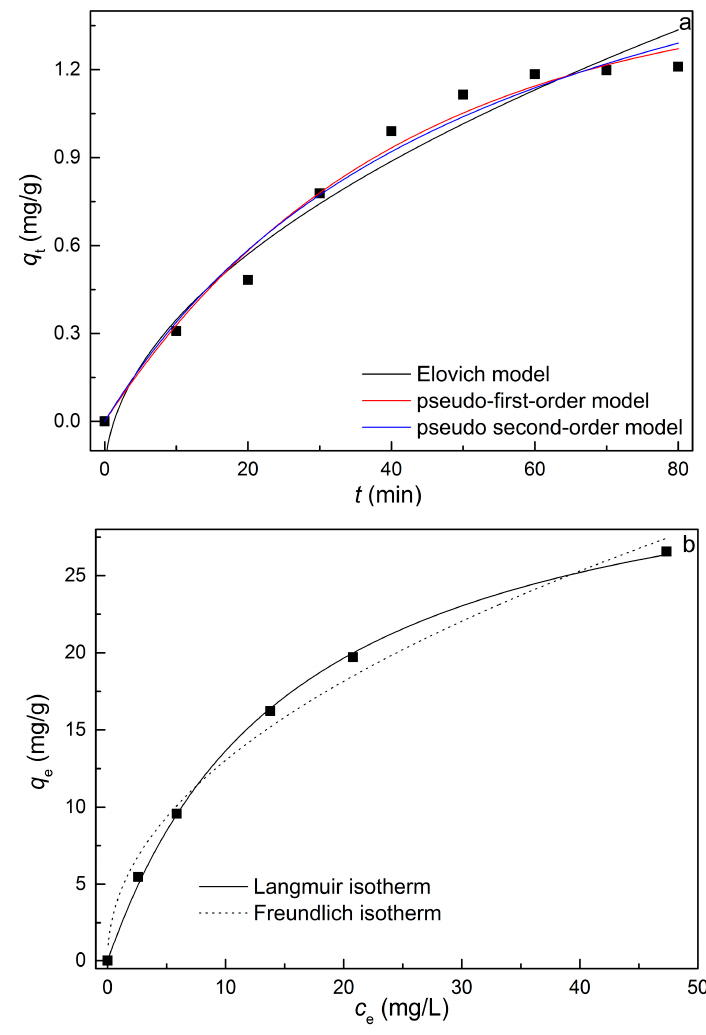
Figure 5. ( a ) Adsorption kinetics and ( b ) isotherm of methylene blue (MB) dye on REC/Fe 3 O 4 /ZnO